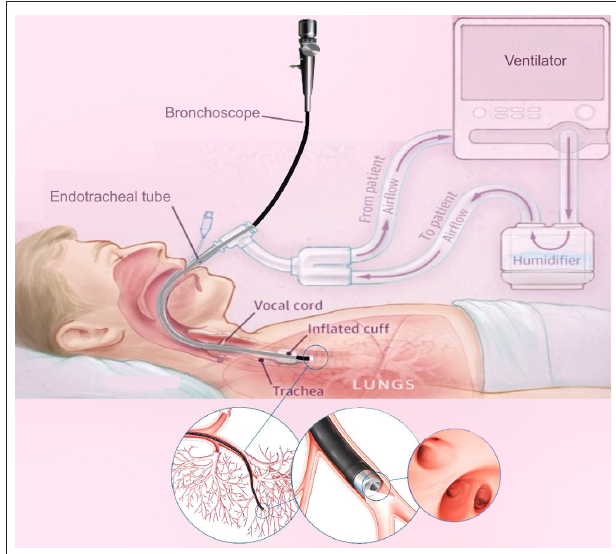
FIGURE 1 | A schematic of lung bronchoscopy in ICU, showcasing the insertion of the robotic bronchoscope through the mechanical ventilator and inside the